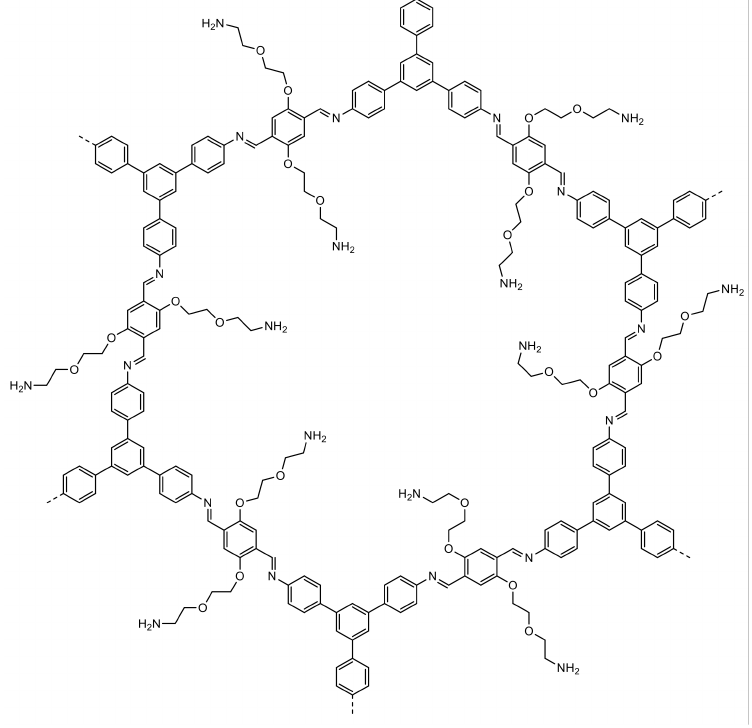
Figure 10. Structure of [NH 2 ]-COF.